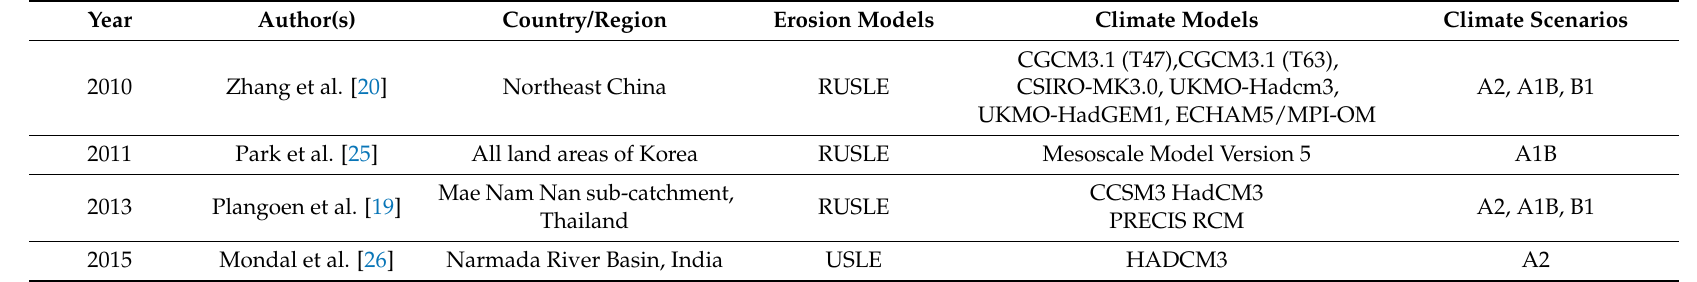
Table 2. Previous studies of impacts of projected climate change on soil erosion in Asian case using RUSLE and